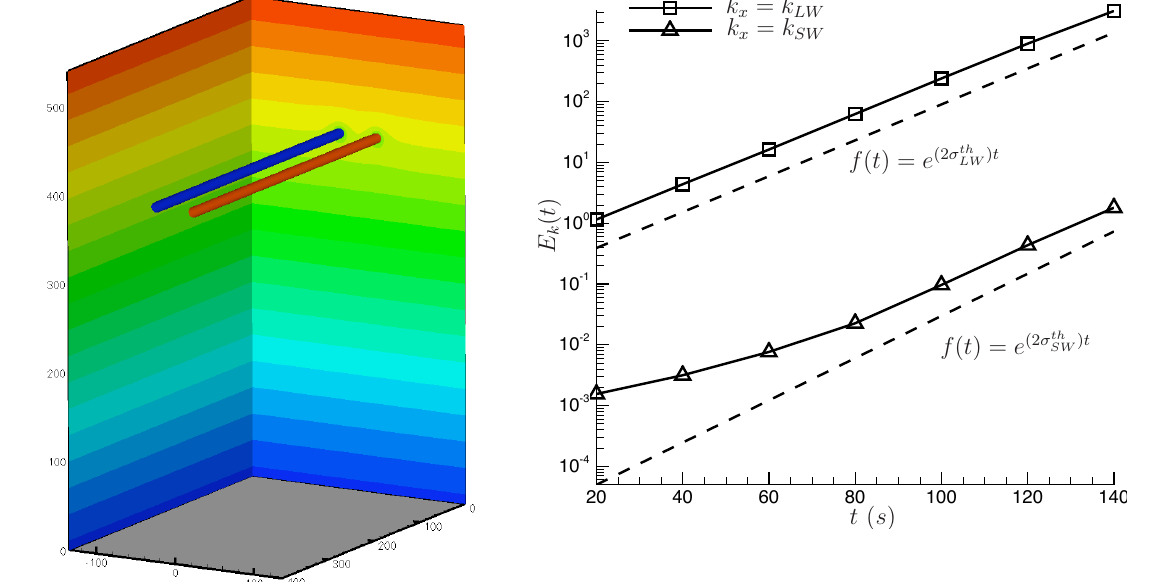
Fig. 2. Time evolution of the growth rates of the short and long wave instabilities in the non-stratified case (run V 0). The dashed lines indicates the theoretical growth rates (Widnall et al., 1971): = 0 . 041s − 1 and σ th = 0 . 034s − 1 σ th SW LW